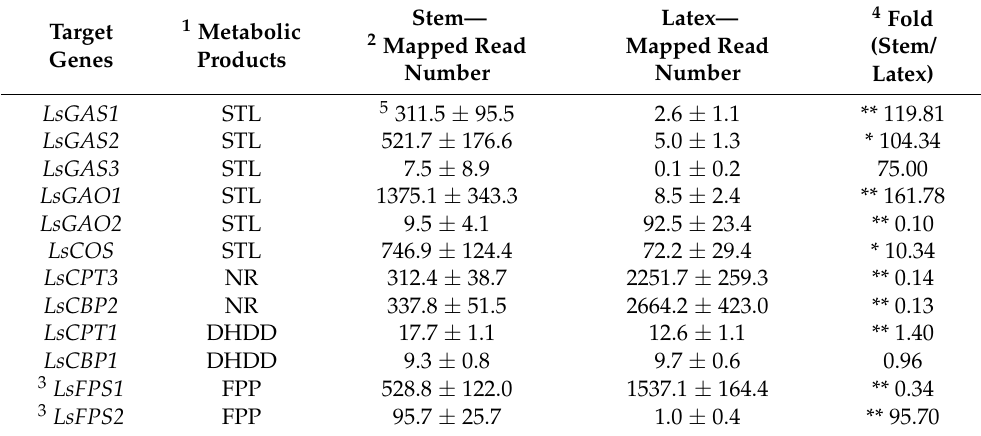
Table 1. Quantitative read maps for transcripts in STL-, NR-, and DHDD-biosynthesis in lettuce latex and whole stems, including